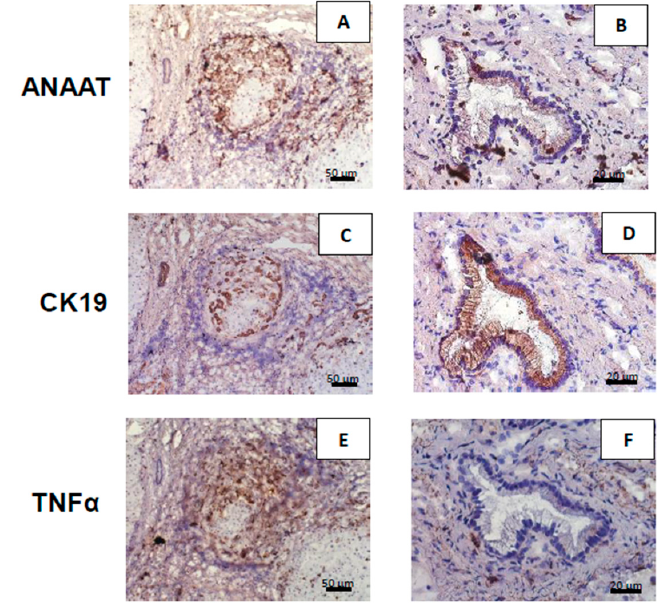
Figure 2. Hepatic expressions of aralkylamine N-acetyltransferase (AANAT), CK19, and TNF α protein in primary biliary cholangitis (PBC) patients. Positive immunohistochemical staining (dark brown) of AANAT, CK19, and TNF α in cirrhotic liver tissues were observed on the edges of regenerative nodules ( A , C , E ), and in bile ducts ( B , D , F ), respectively. ( A , B ) AANAT was ubiquitous in the liver tissue of PBC patients. ( C , D ) CK19 was localized in cholangiocytes in areas of ductular reactions. Bile ducts are marked by asterisks. ( E , F ) TNF α was localized primarily on the perimeter of nodules, but was absent in the cholangiocytes of the large bile duct.